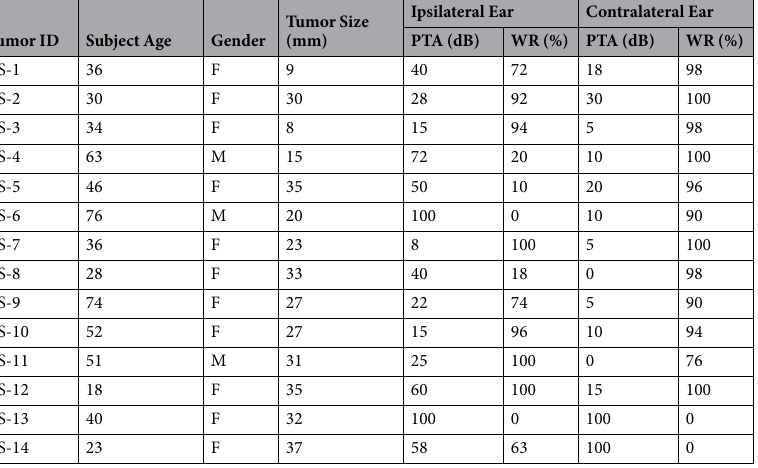
Table 1. Demographics of patients selected in the study. Tumor ID, subject age, gender, tumor size (mm, largest transverse dimension), pure tone average (PTA, dB), and word recognition score (WR, %) for the ipsilateral and contralateral ears to VS are